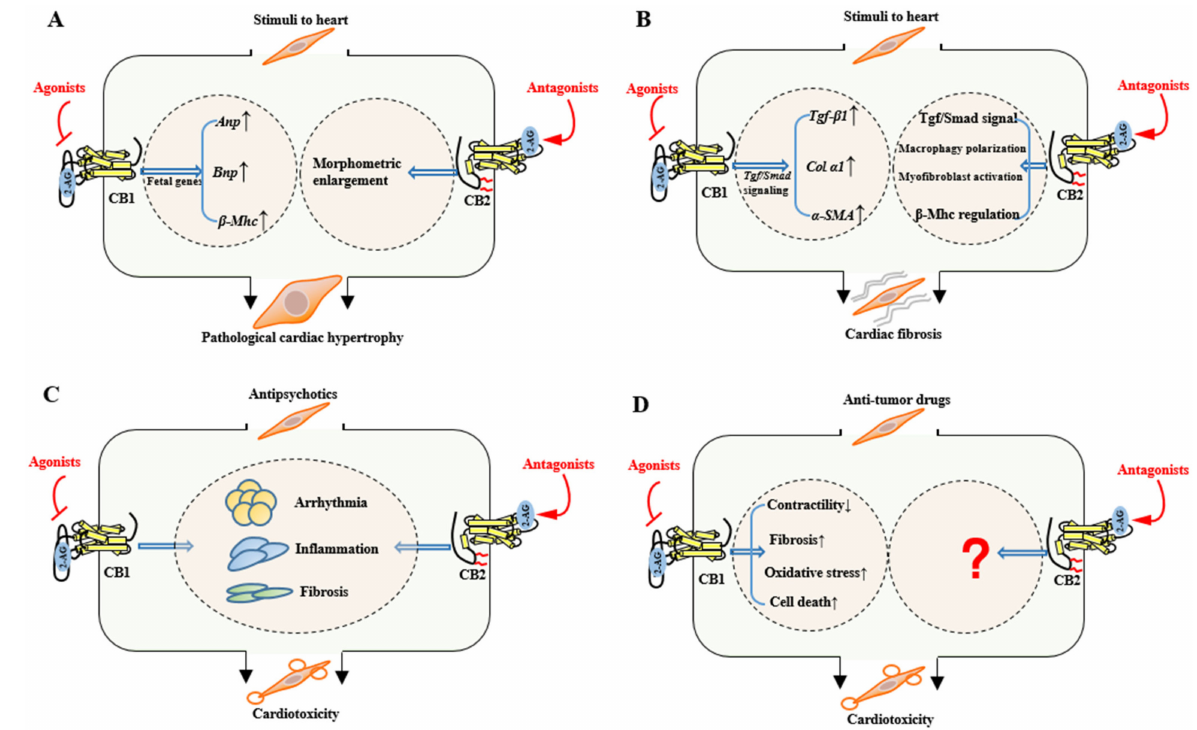
Figure 4. Summary of the functional differences between cannabinoid CB1 and CB2 receptors in pathological cardiac hypertrophy ( A ), cardiac fibrosis ( B ), antipsychotic cardiotoxicity ( C ), and anti-tumor drug cardiotoxicity ( D ). The 2-AG is depicted as a representative endogenous ligand of cannabinoid receptors. ↓ indicates inhibition and ↑ indicates